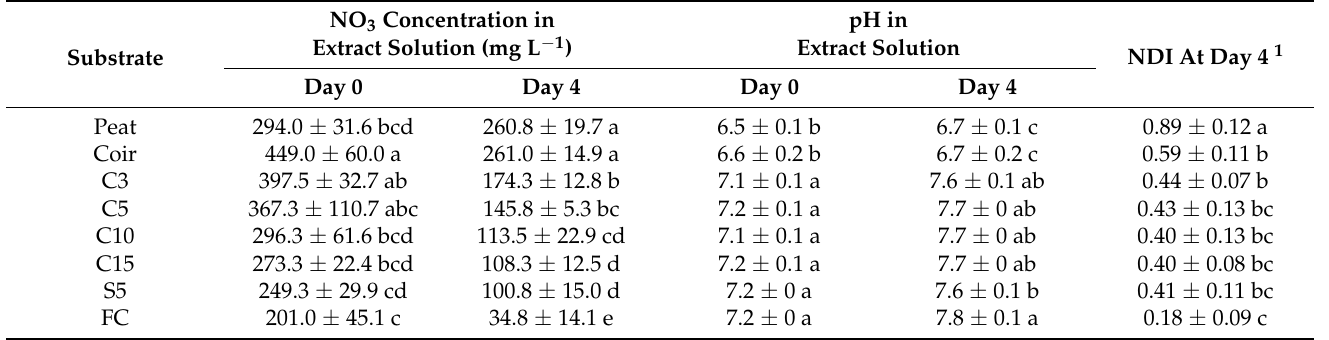
Table 8. Nitrogen drawdown index of peat, coir, and six processed miscanthus substrates.